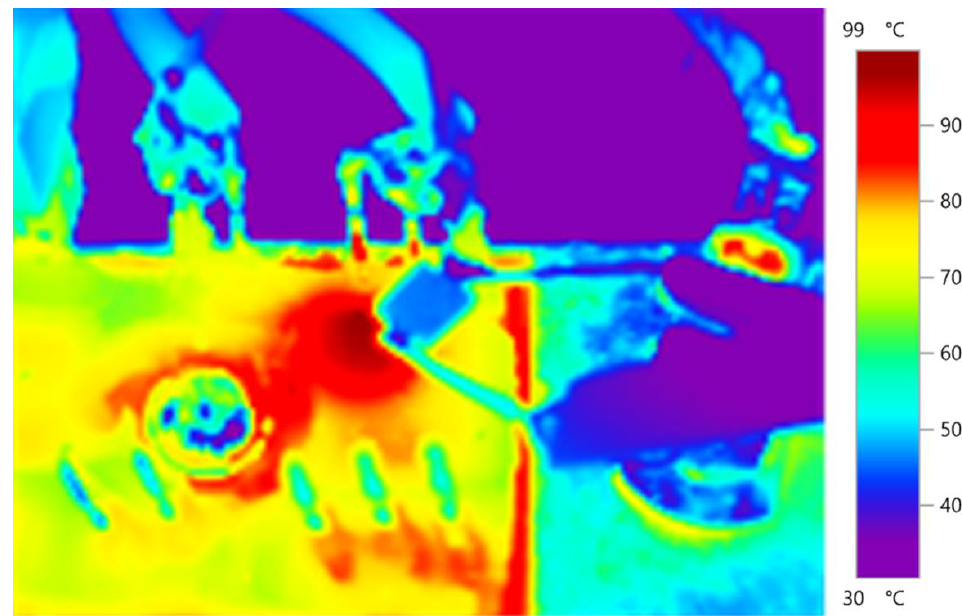
Figure 4. Thermal map of a SiC power module in the case of a current injection in the body diode.